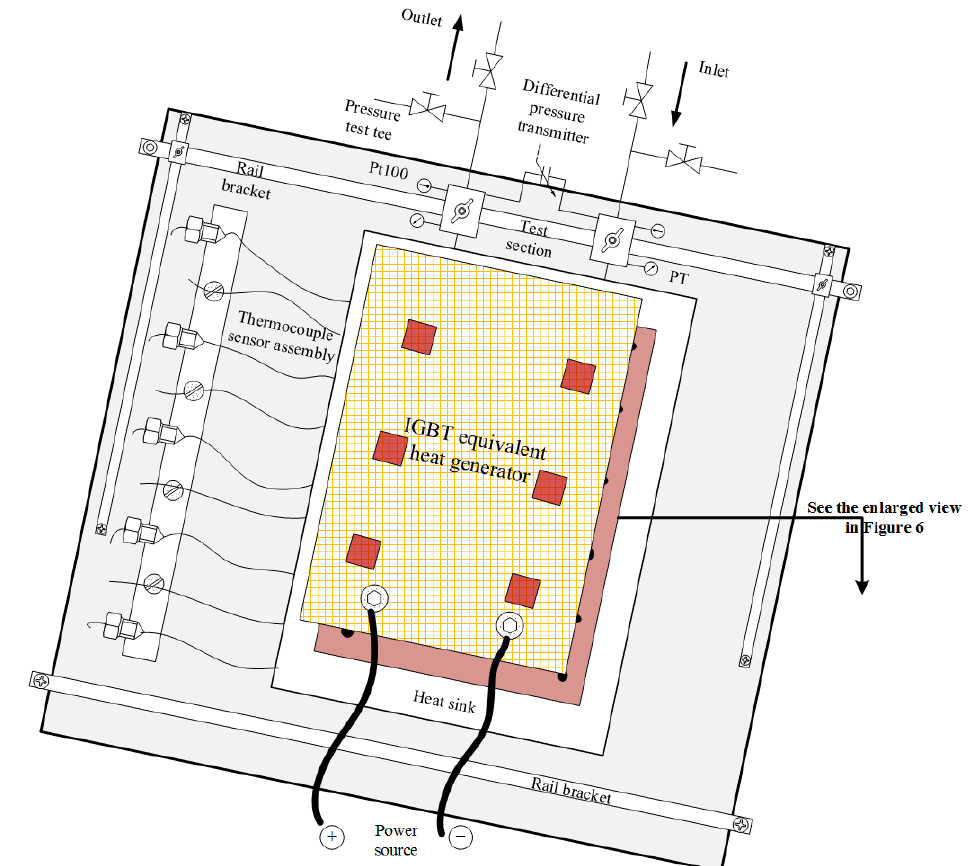
Figure 5. Testing platform designed for test section installation.